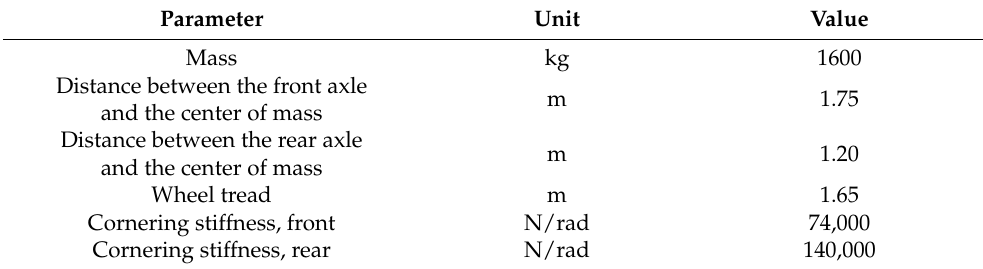
Table 2. Vehicle specification.